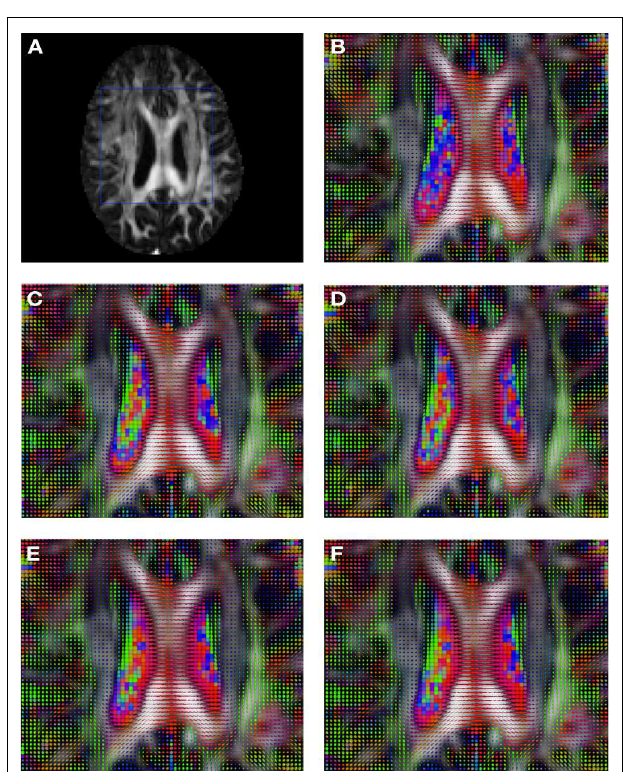
FIGURE 5 | Comparison of the tensors (represented as RGB color coded glyphs) of Subject3-2 and the tensors Subject3 registered to Subject3-2. (A) Subject3-2 FA indicating the region selected to show the tensors. (B) Subject3-2 tensors. Registered tensors of Subject3 using (C) FLIRT-volumes-SH, (D) FLIRT4D-AI, (E) MedINRIA-volumes-SH, and (F)